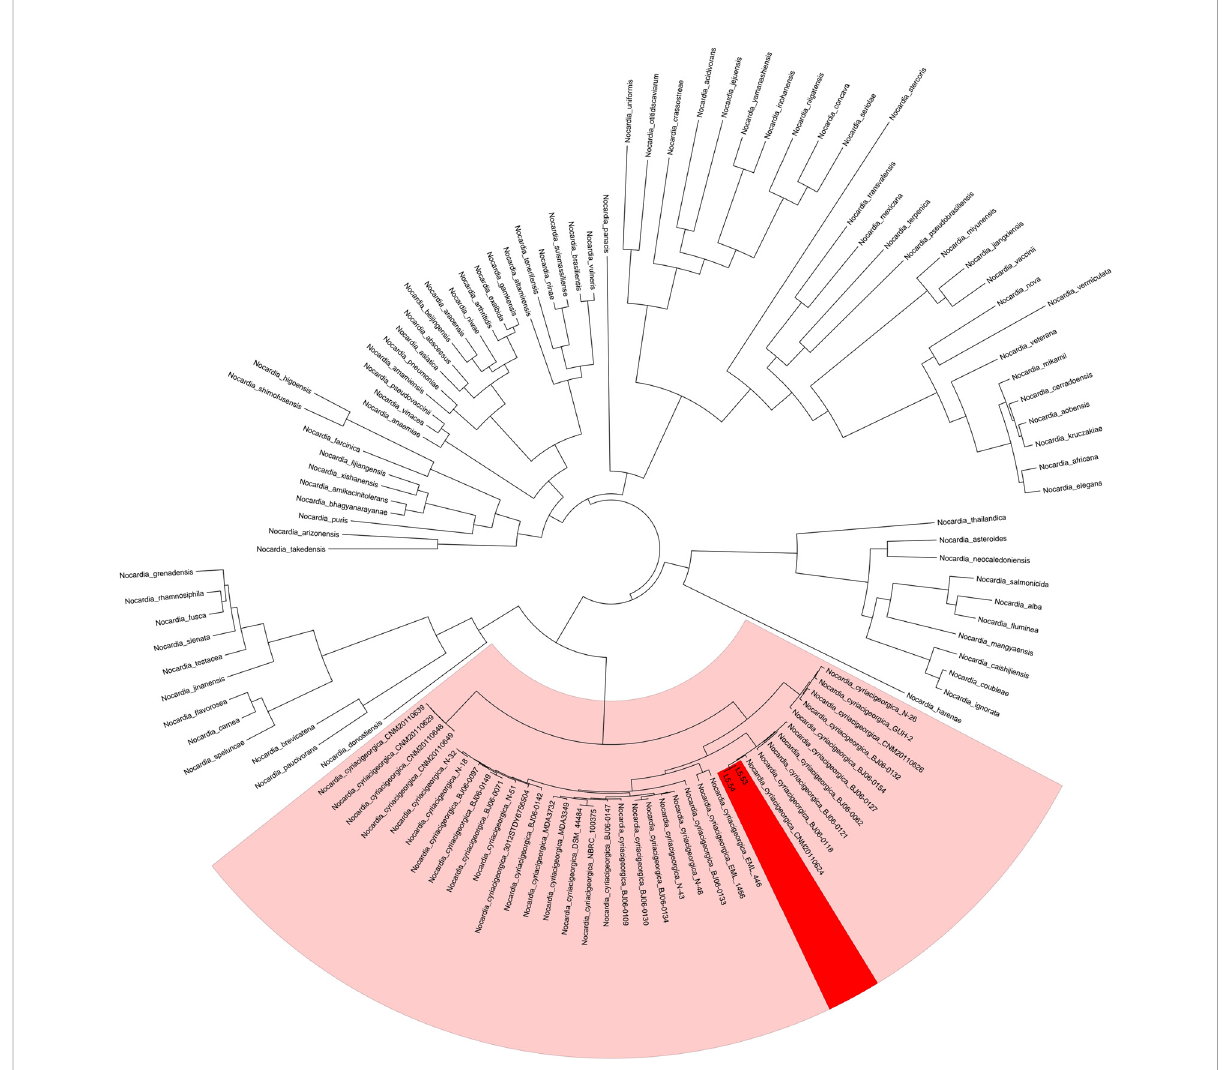
FIGURE 3 Gene family cluster analysis evolutionary tree of strains L5.53 and L5.54. The 117 protein sequences of genus Nocardia , including samples L5.53 and L5.54, were clustered and the evolutionary tree was constructed. It could be seen that L5.53 and L5.54 were Nocardia cyriacigeorgica , which formed a robust supported clade within N. cyriacigeorgica